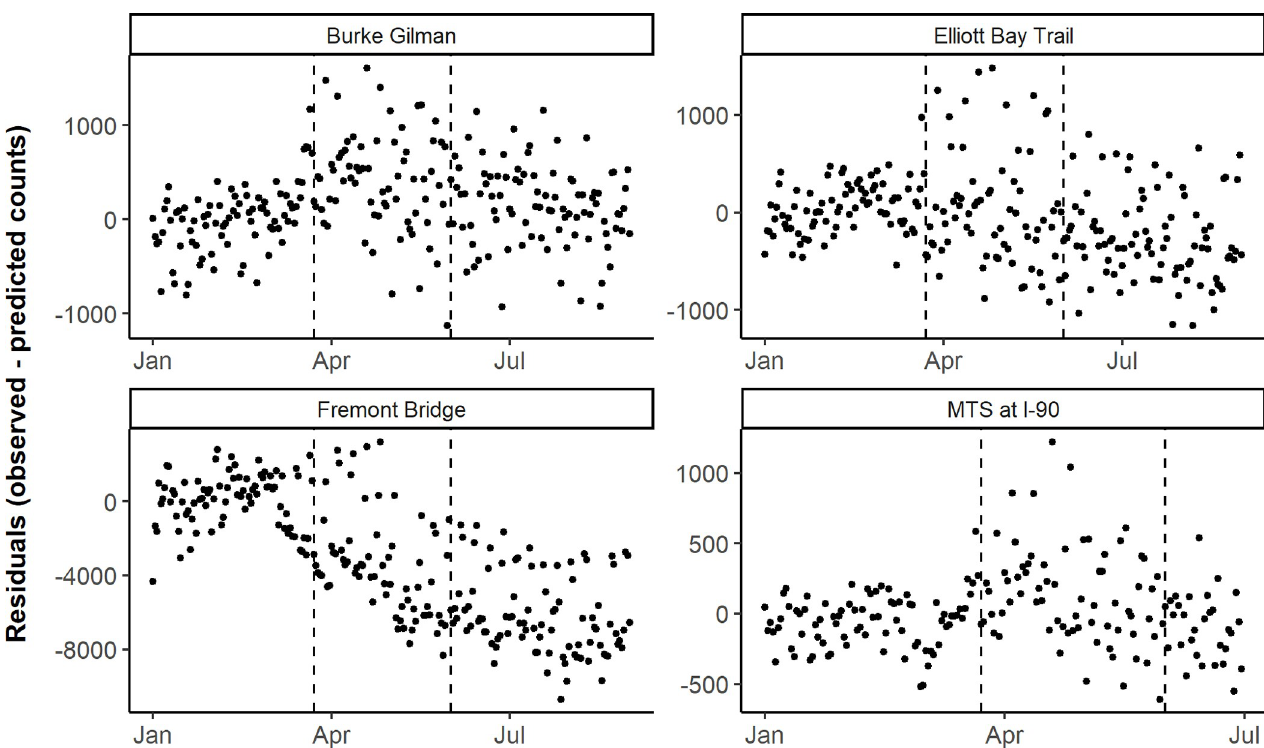
Fig 6. Daily observed minus predicted bicycle counts by counter location, before, during, and after the Stay Home order in Seattle. The first vertical dashed line corresponds to the Stay Home order on March 23, 2020, and the second vertical dashed line corresponds to the end of the Stay order on May 31, 2020 in Washington state. Note the y-axis scales vary between plots to facilitate the interpretation of